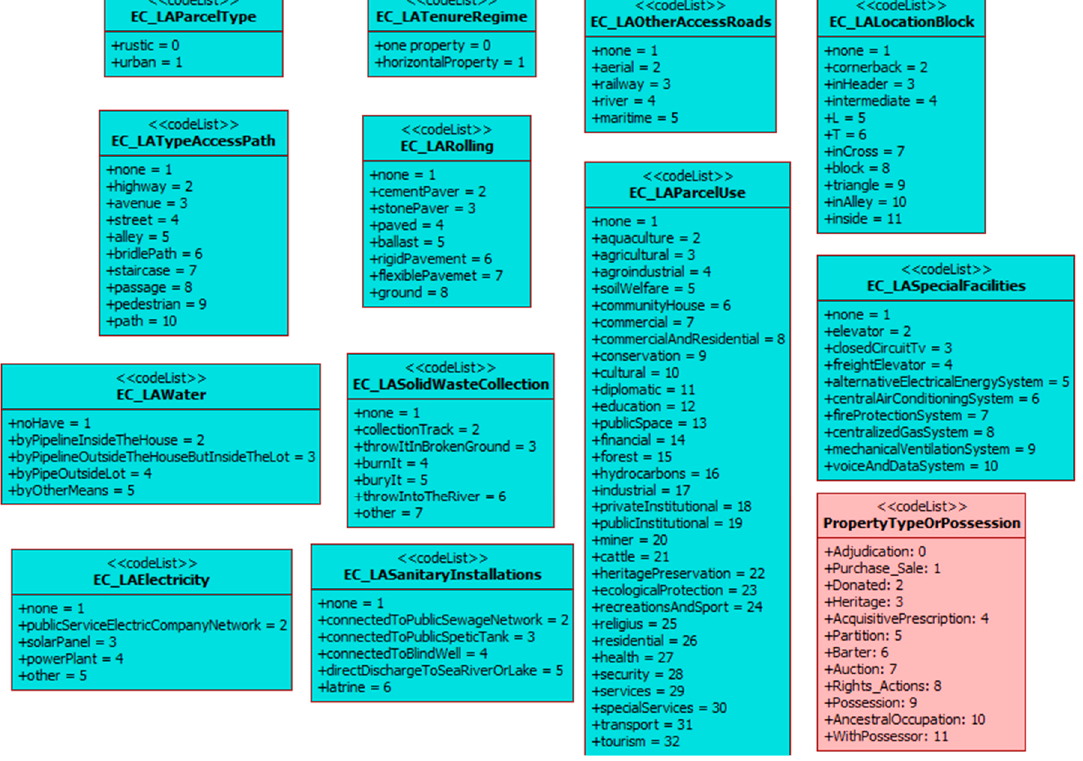
Figure 6. Code lists of the Ecuadorian LADM country profile.